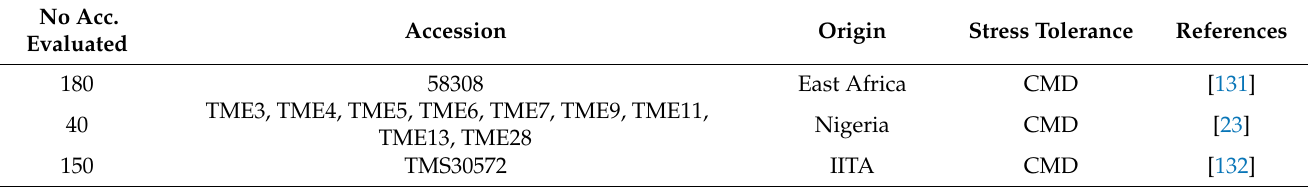
Table 2. Disease resistance reported in selected Manihot esculenta and related cassava